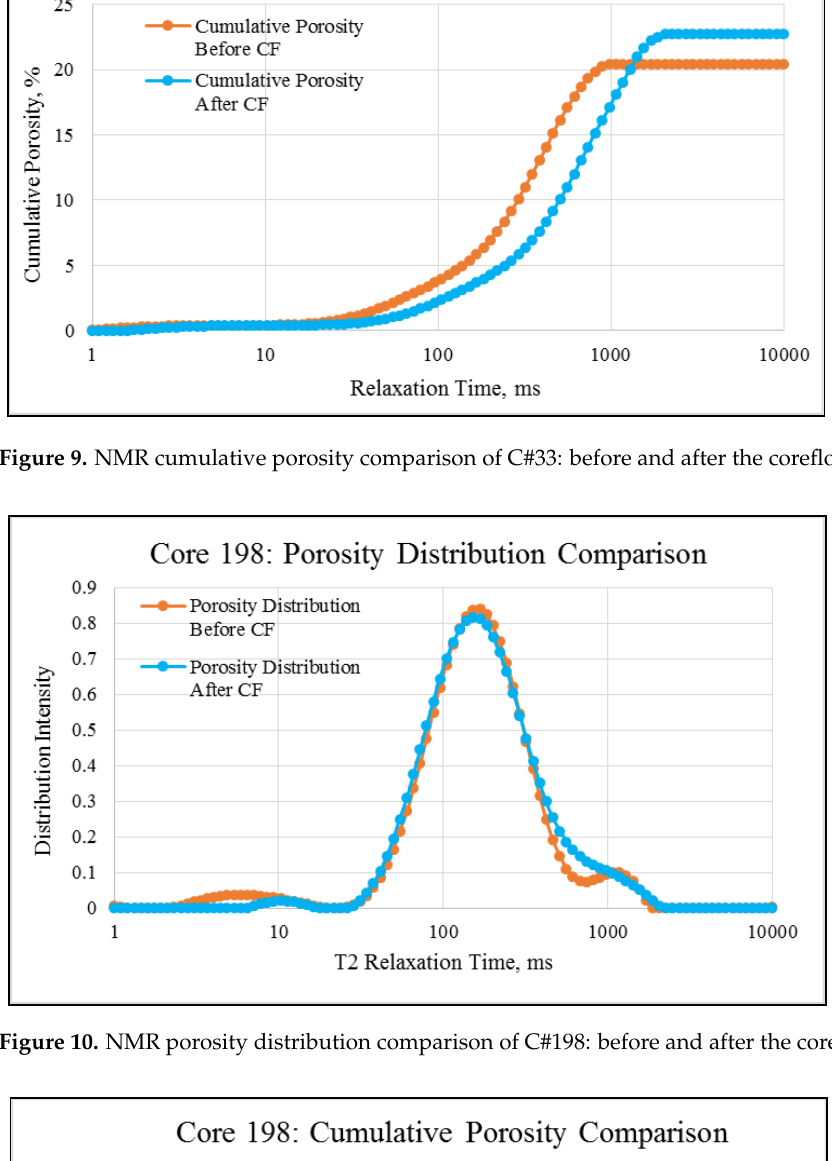
Figure 8. NMR porosity distribution comparison of C#33: before and after the coreflood.